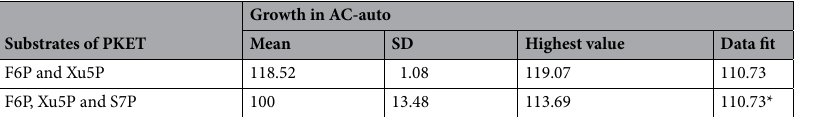
Table 3. In silico analysis of substrates dependent tuned PKET pathway for theoretical maximal growth under AC-auto in Synechocystis . Mean and SD represent the statistical data from parameter estimation. Highest growth value denotes the maximal theoretical growth for a particular set of substrates. Data fit indicates the estimated growth rate based on experimental data (Δ pket1 ). Asterisks signifies data fit for scenario with S7P allowed to be metabolized by PKETs but the best fit considered zero activity via S7P